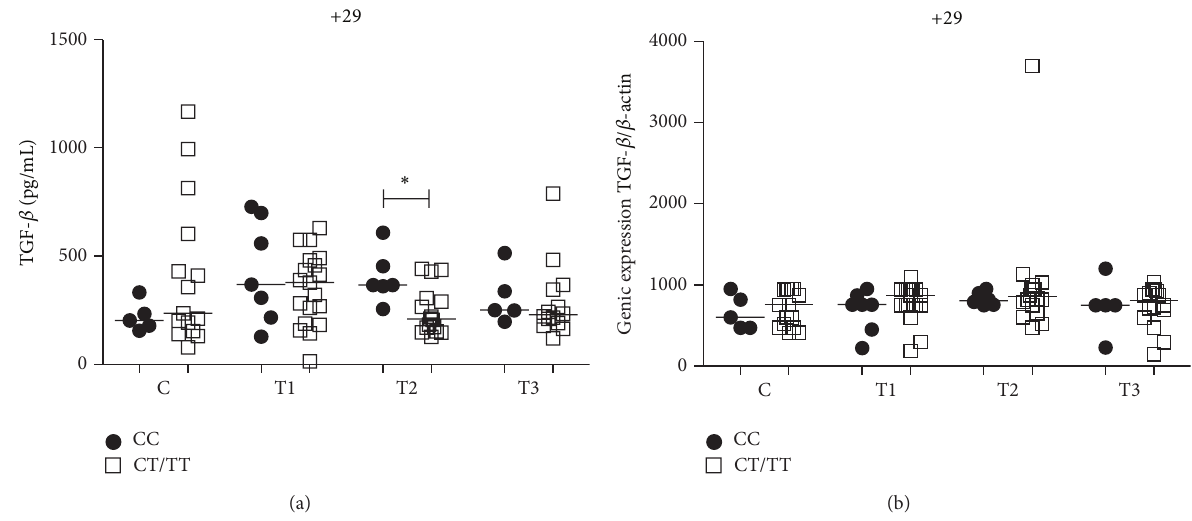
Figure 7: Influence of TGF 𝛽 1 +29C/T gene SNP on TGF- 𝛽 plasma levels (a) and mRNA expression (b) in the control group (C) and PTB patients at three time points of the treatment: T1 (after diagnosis and first month), T2 (three months), and T3 (six months). Data are shown as median levels. ∗ 𝑃 < 0.05